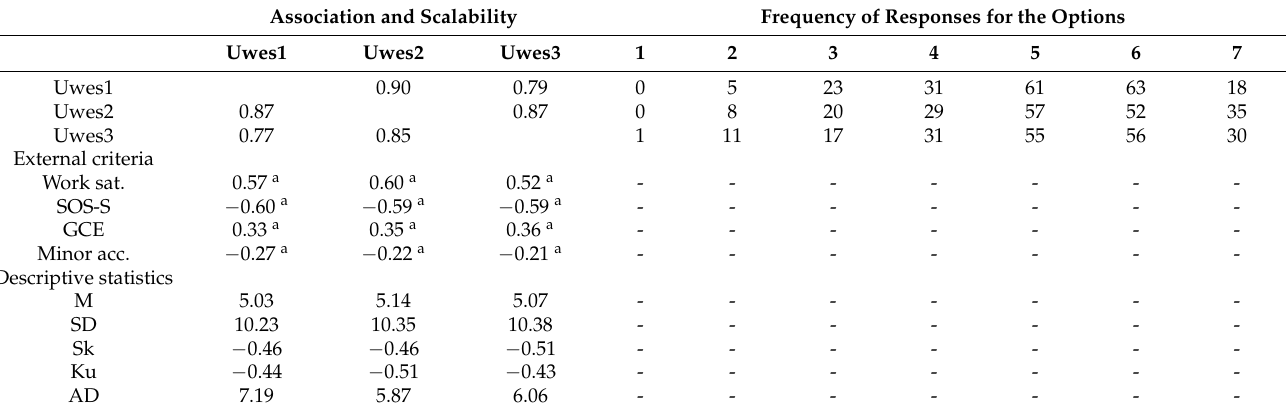
Table 1. Correlational, descriptive and structural statistics of the UWES-3